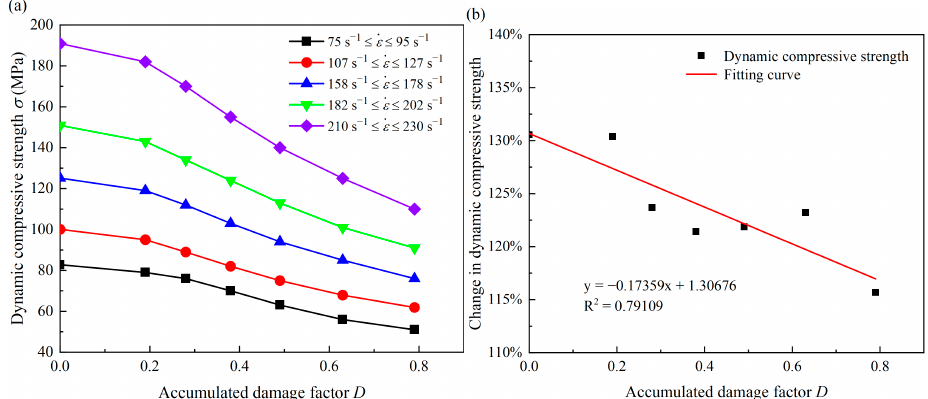
Figure 17. Variation in ( a ) the dynamic compressive strength of sandstone and ( b ) change in sandstone strength with accumulated damage.